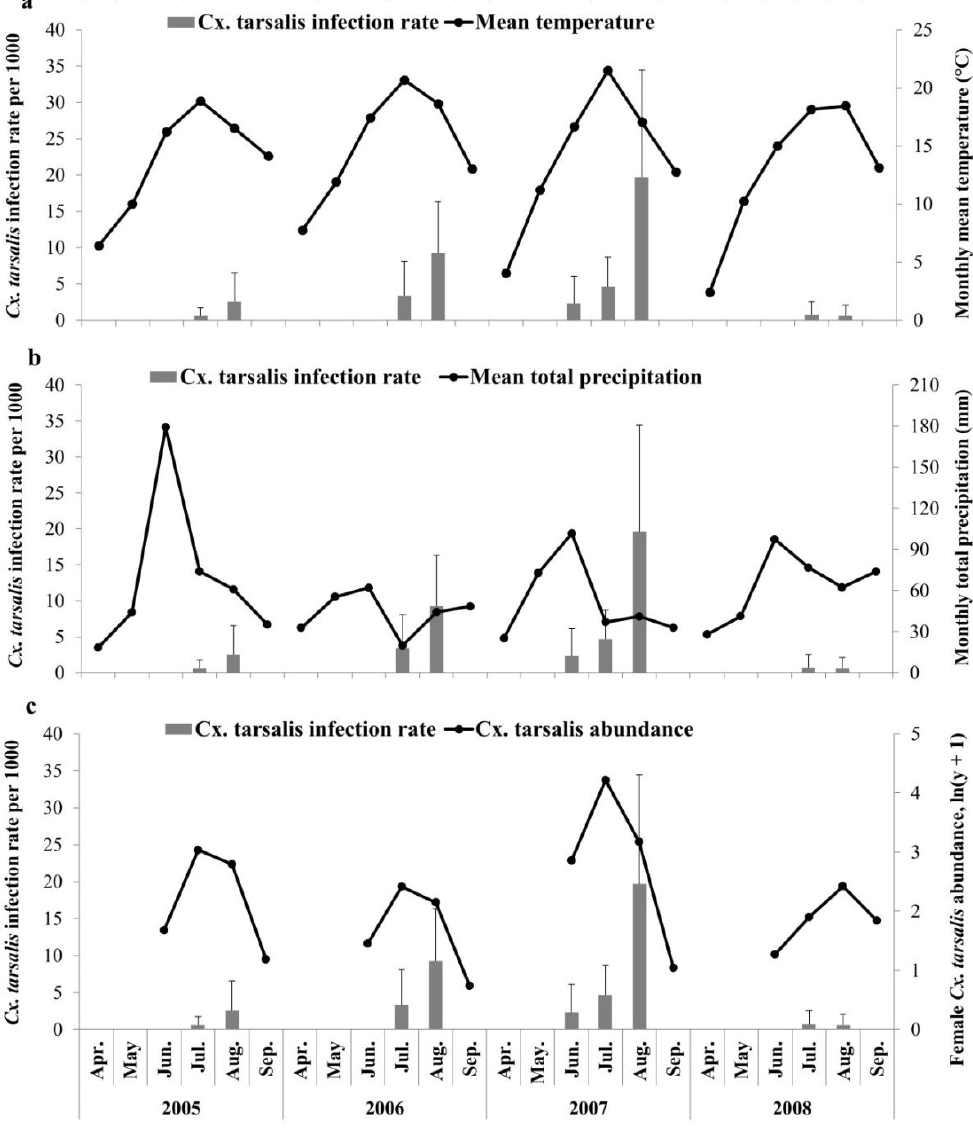
Figure 2. Temporal trends of ( a ) Monthly mean temperature (unit 1 °C). ( b ) Monthly total precipitation (unit 1 mm). ( c ) Monthly mean abundance of Cx. tarsalis , ln(y + 1) transformed, compared to monthly mean WNV infection rate in female Cx. tarsalis in the Canadian prairies. Error bar indicates the standard deviation of mean Cx. tarsalis infection